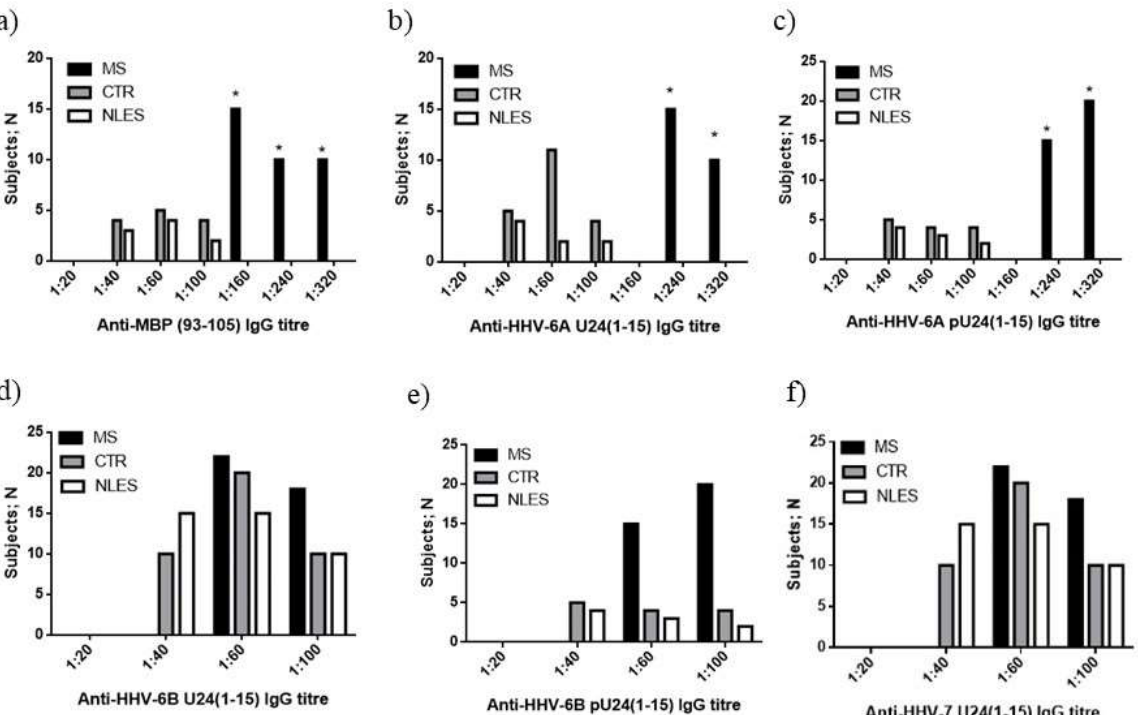
Figure 6. IgG titers, measured in the plasma samples of 40 MS—RRMS patients; 40 CTR—healthy subjects; 40 NLES—neurolupus patients, specific for ( a ) MBP 93-105 , ( b ) U24-6A 1-15 , ( c ) pU24-6A 1-15 , ( d ) U24-6B 1-15 , ( e ) pU24-6B 1-15 , and ( f ) U24-7 1-15 (cf. Table 1 for sequences). * significant p value, Fisher exact test.